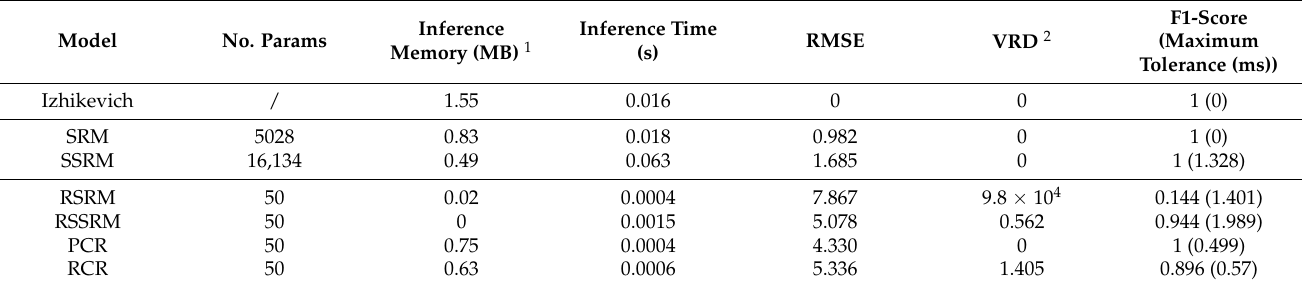
Table 4. Average performance on one-spike firing behaviors.